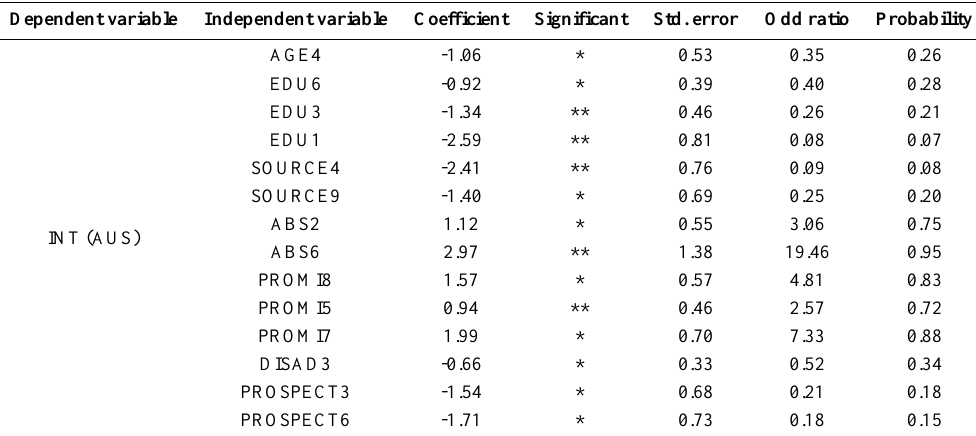
Table B-3. Limited interest in AI-based services from the local community Dependent variable Independent variable